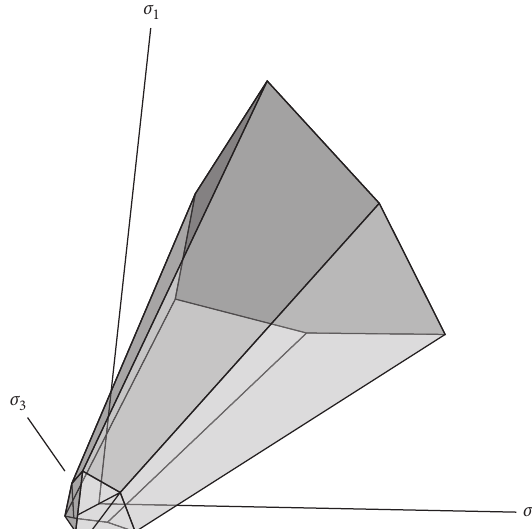
Figure 5: Schematic diagram of the composed strength failure, which can be derived according to the